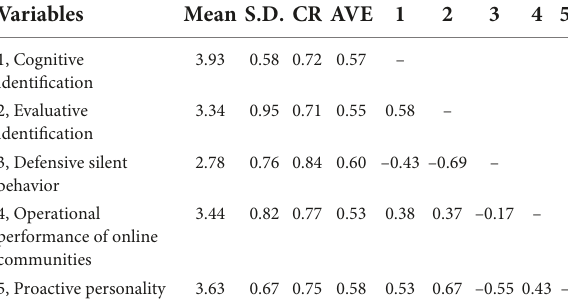
TABLE 3 The results of validity test.